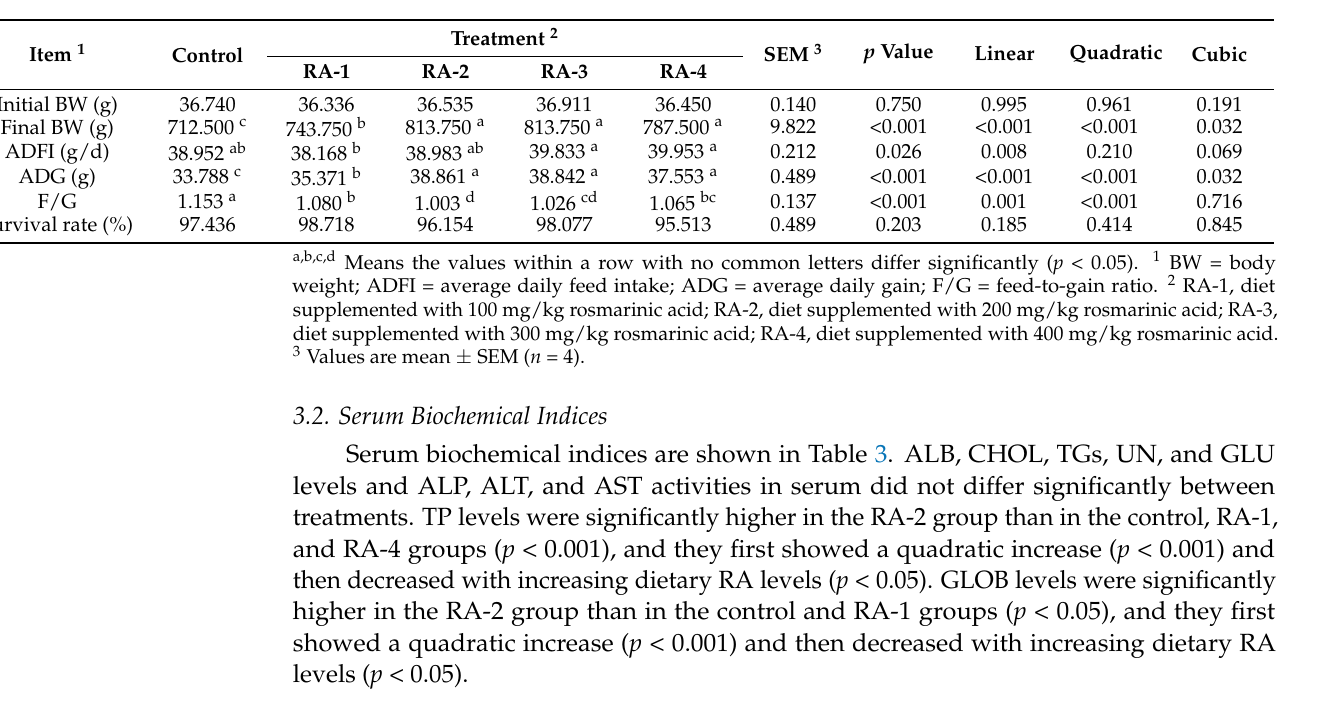
Table 2. The effect of dietary supplementation with rosmarinic acid (RA) on growth performance of broilers.